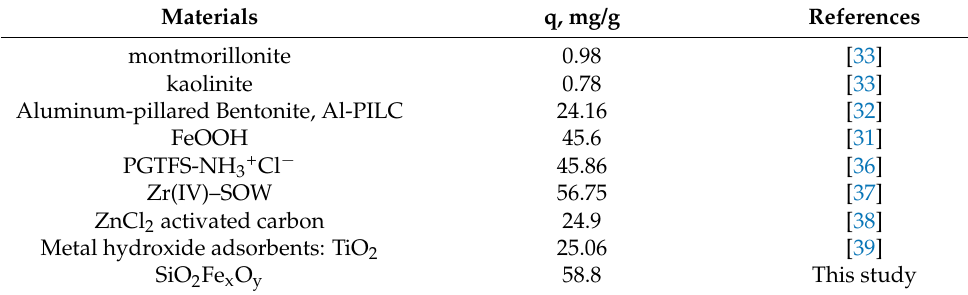
Table 7. Adsorption performance